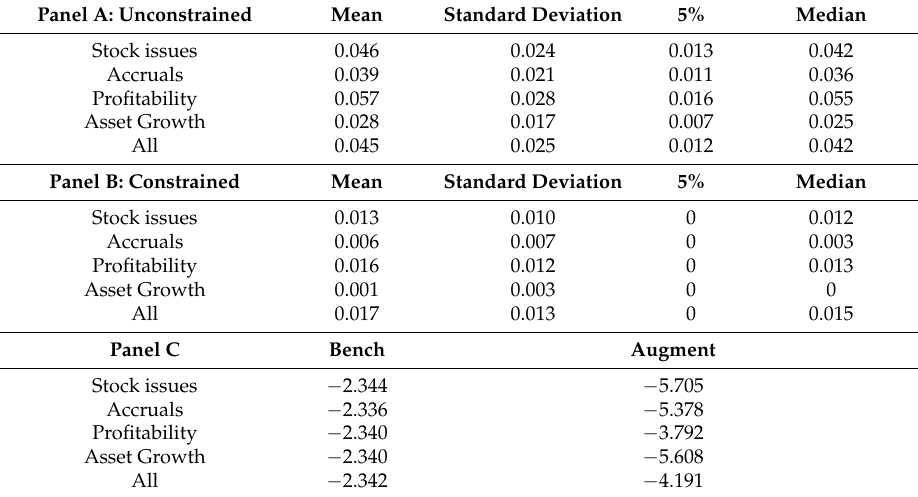
Table 7. Posterior Distribution of the DSharpe Measure of the Additional Model 2 Characteristics: Large